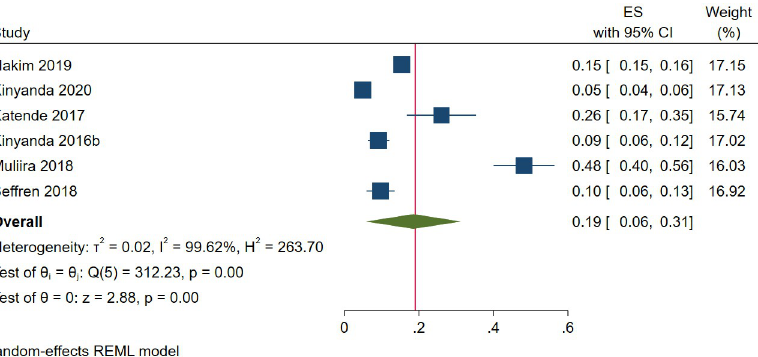
Fig 13. Forest plot on the prevalence of depression among caregivers of selected patient groups in Uganda.